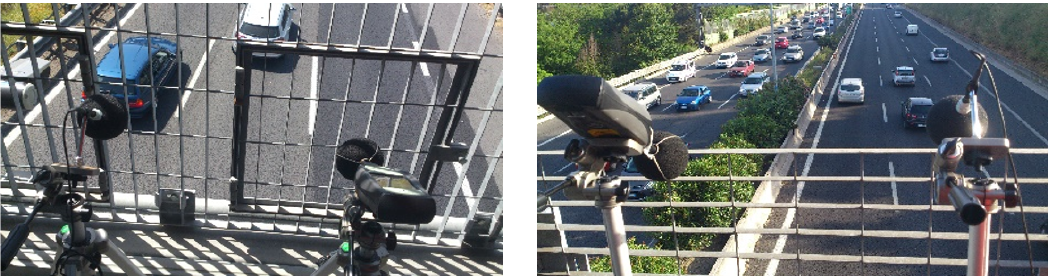
Figure 2. Examples of the recording setup installed in the suburban scenario (Rome).